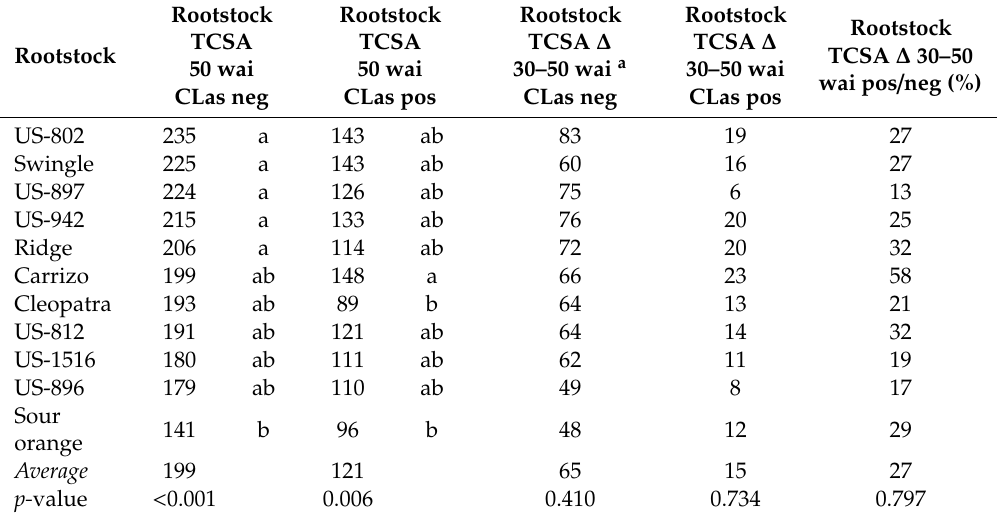
Table 5. Rootstock size and growth, as trunk cross-sectional area (TCSA) in mm 2